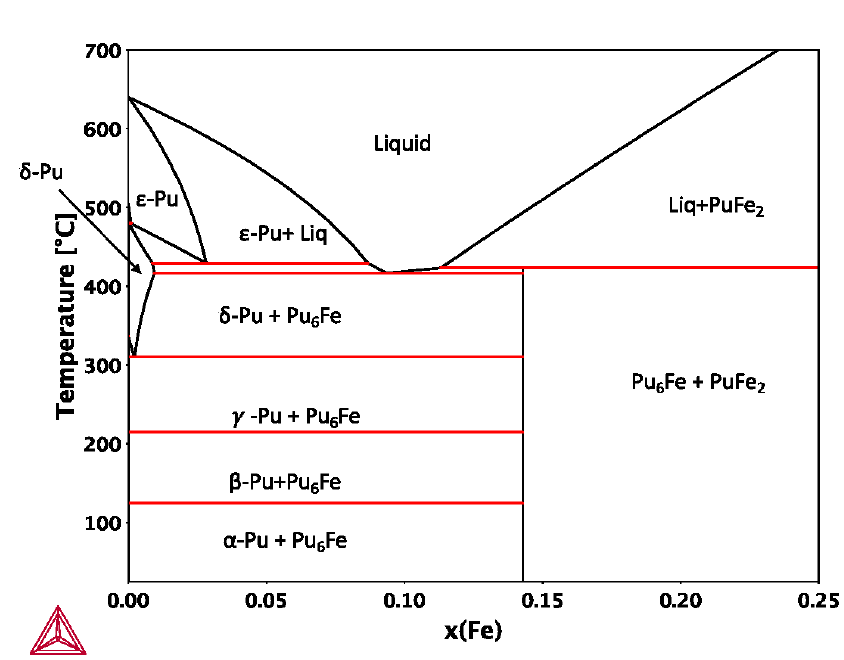
Figure 2. Calculated Pu-rich side of the Pu-Fe phase diagram based on the present CALPHAD assessment.